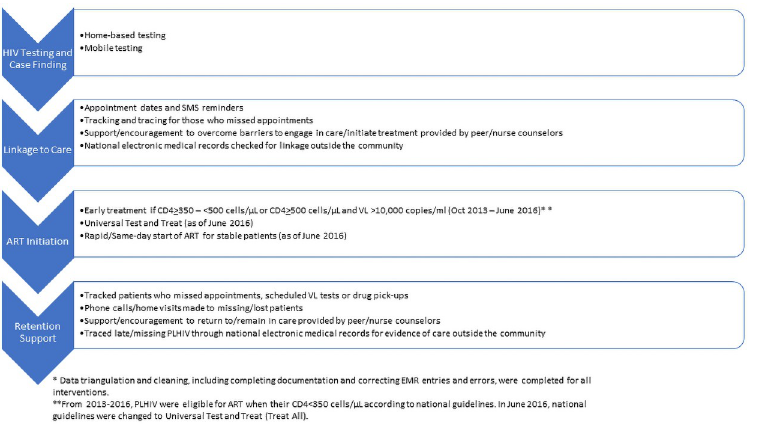
Fig 1. BCPP interventions across the clinical